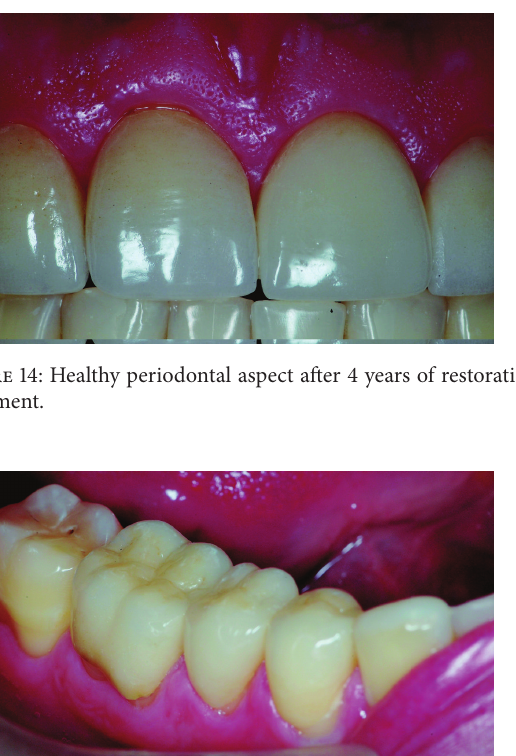
Figure 13: Clinical aspect of the restorations after 4 years of followup.